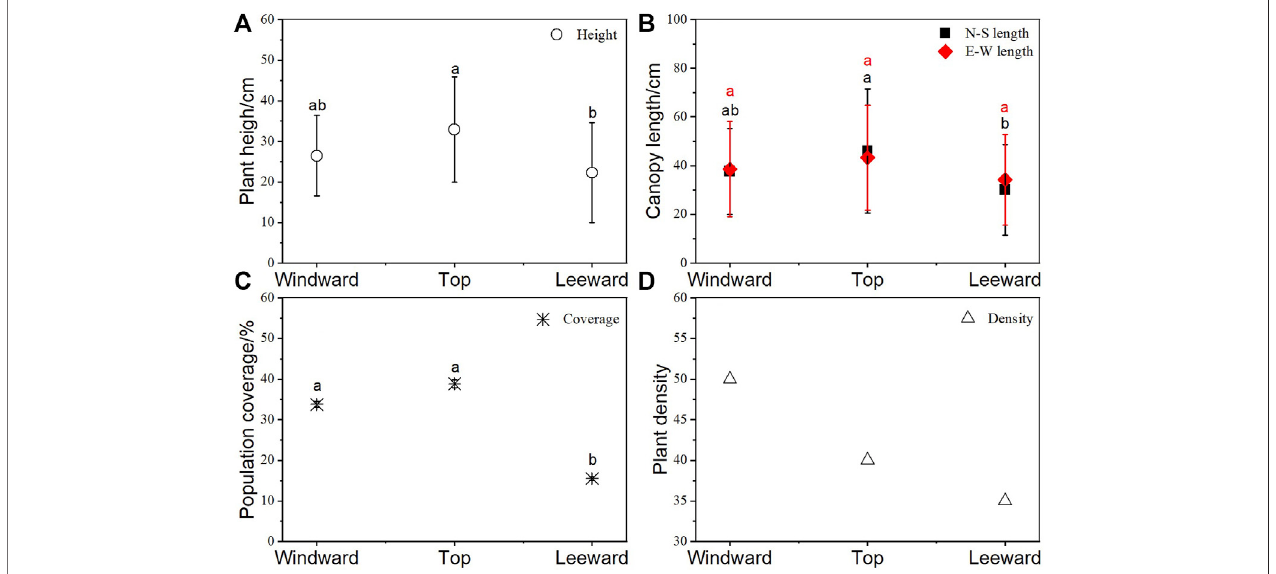
FIGURE 3 | Artemisia ordosica (Ao) growth features in positions with different dune geomorphology. (A) Height, (B) crown width of different orientation, (C) coverage, and (D) density. The same letter means that there is no signi fi cant difference between different positions of dune ( p > 0.05), whereas different letters refer to signi fi cant differences between micro-landforms in dune ( p < 0.05).